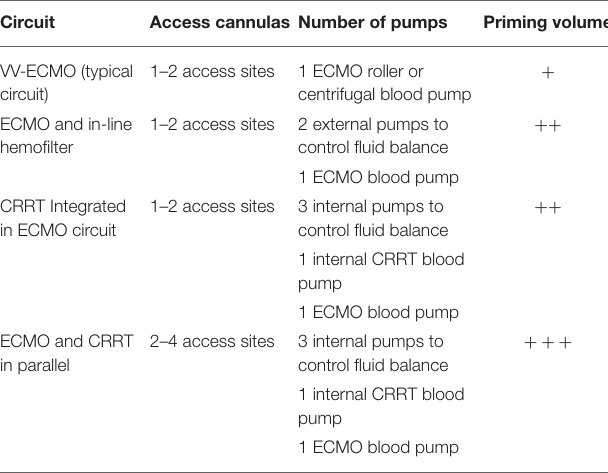
TABLE 2 | Comparison of number or access sites, number of pumps, and priming volume required for different ECMO and CRRT circuit connections. Circuit Access cannulas Number of pumps Priming